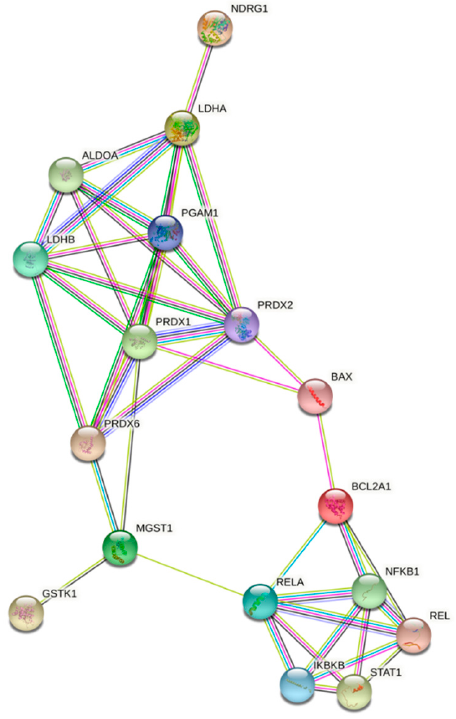
Figure 5. Protein–protein interaction (PPI) networks of differentially expressed proteins. Line shape indicates the predicted molecular mechanism of action. PPI presented 17 nodes and 33 edges with a PPI enrichment p-value < 1.0 meaning that proteins are biologically connected as a group.